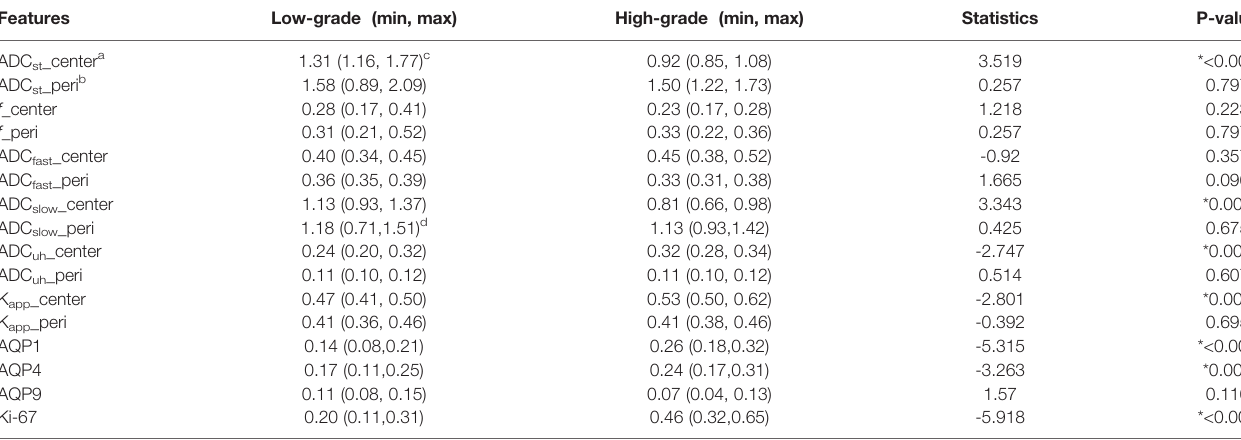
TABLE 1 | The statistical difference analysis of DWI-derived metrics and histological indices between low- and high-grade gliomas.